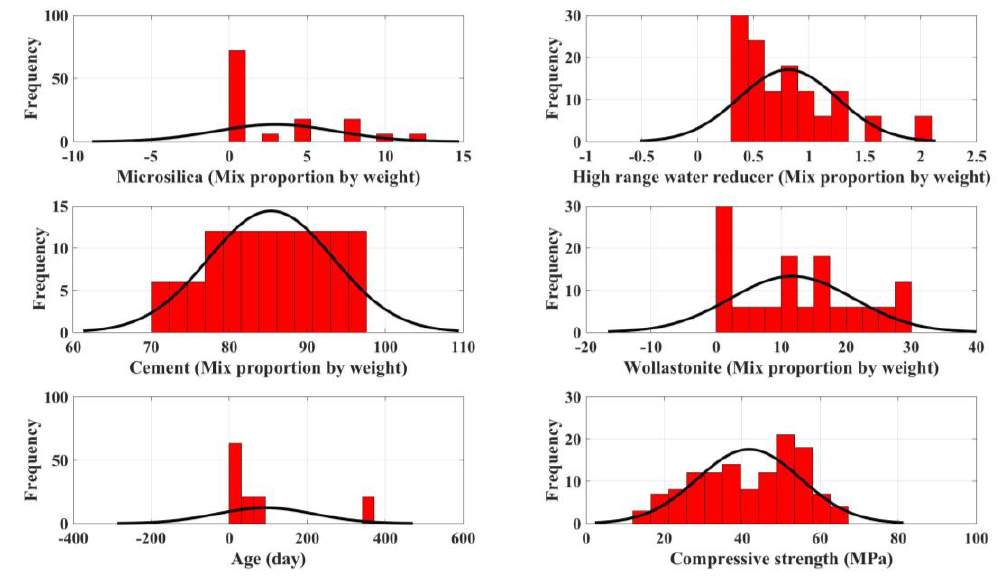
Fig 1. histograms of the considered